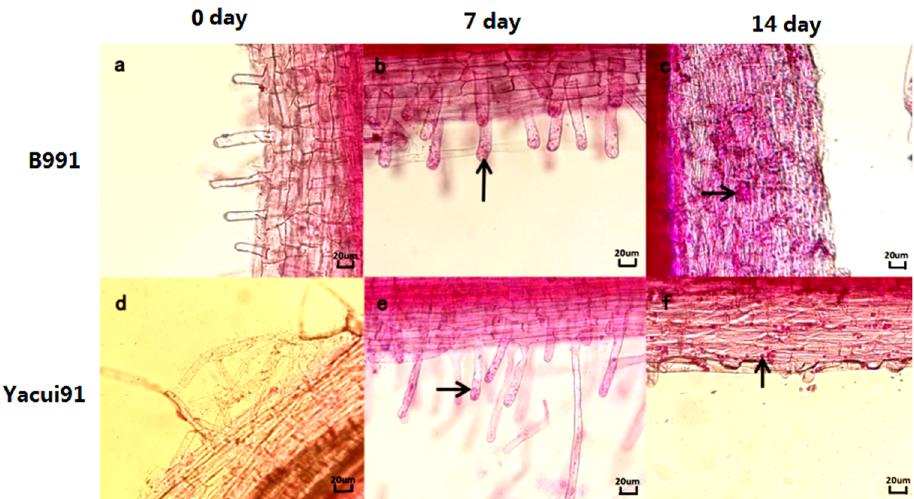
Figure 5. The process of P. brassicae infecting the root cells of resistant and susceptible broccoli varieties. The arrows indicated the conidia and sporangium. ( a – c ) present the profile of susceptible broccoli B991 on the 0th, 7th and 14th day of inoculation with P. brassicae . ( d – f ) present the profile of resistant broccoli “Yacui91” on the 0th, 7th and 14th day of inoculation with P. brassicae .